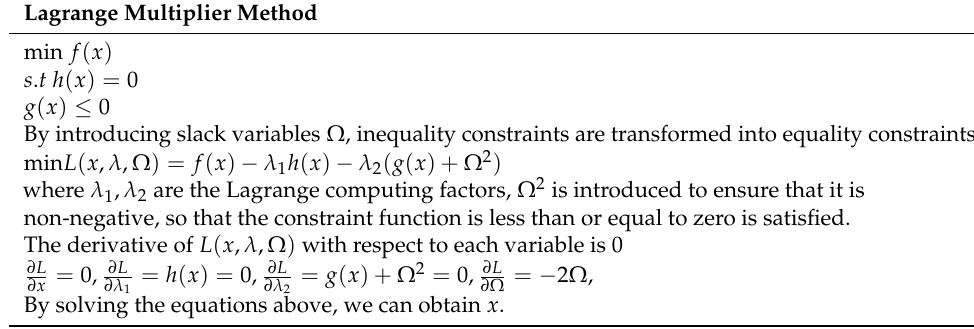
Table 1. Lagrange multiplier method. Lagrange Multiplier